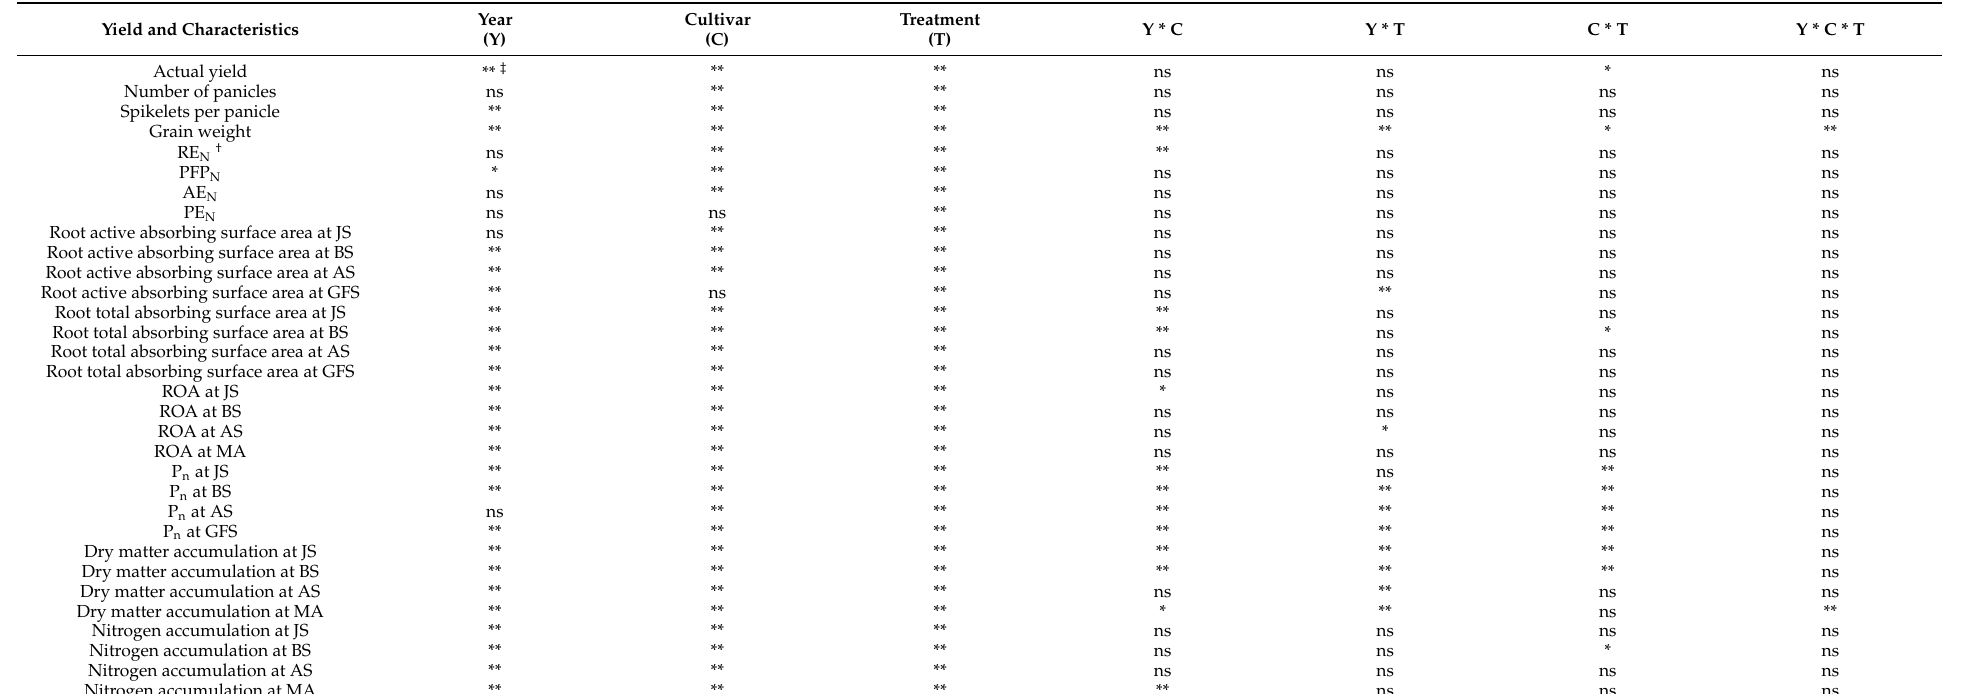
Table A2. Analysis of variance of yield and main measurement